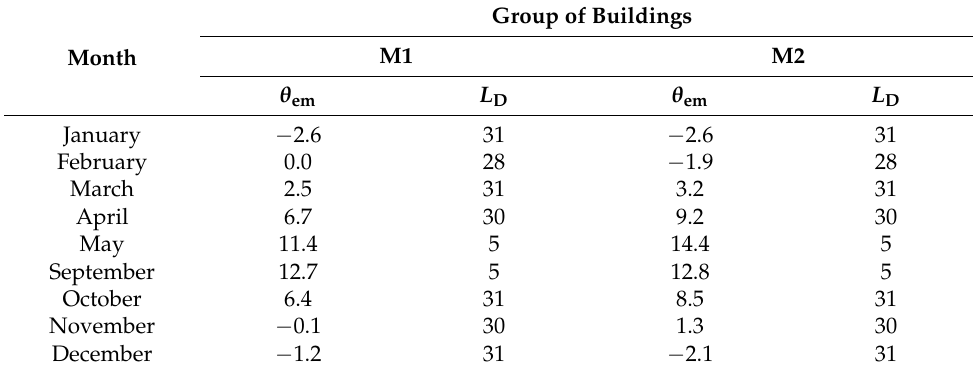
Group of Buildings M1